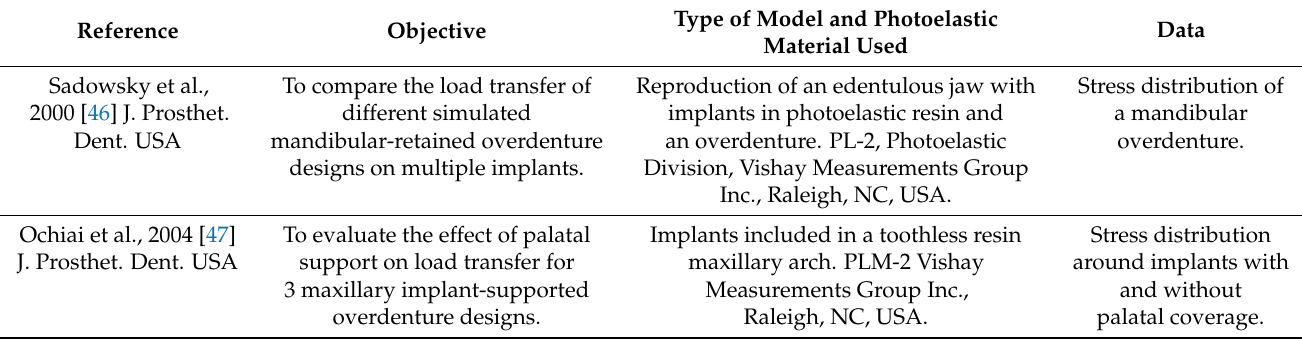
Table 2. Characteristics and findings of studies on implants for total removable prostheses in the dental